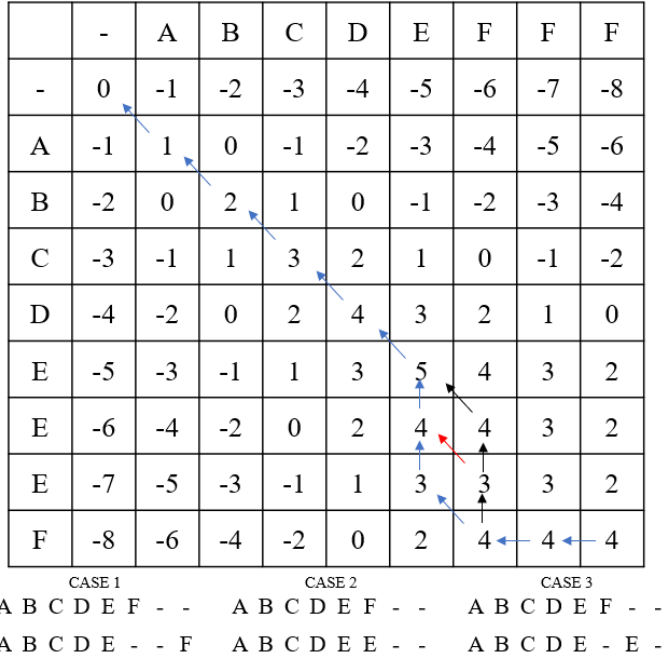
Figure 1. The above example shows the execution result of the Needleman–Wunsch algorithm. The two sequences below the grid are the result of global alignment. The result of the Needleman–Wunsch algorithm provides an optimal alignment result by adding gaps to all target sequences used as inputs.